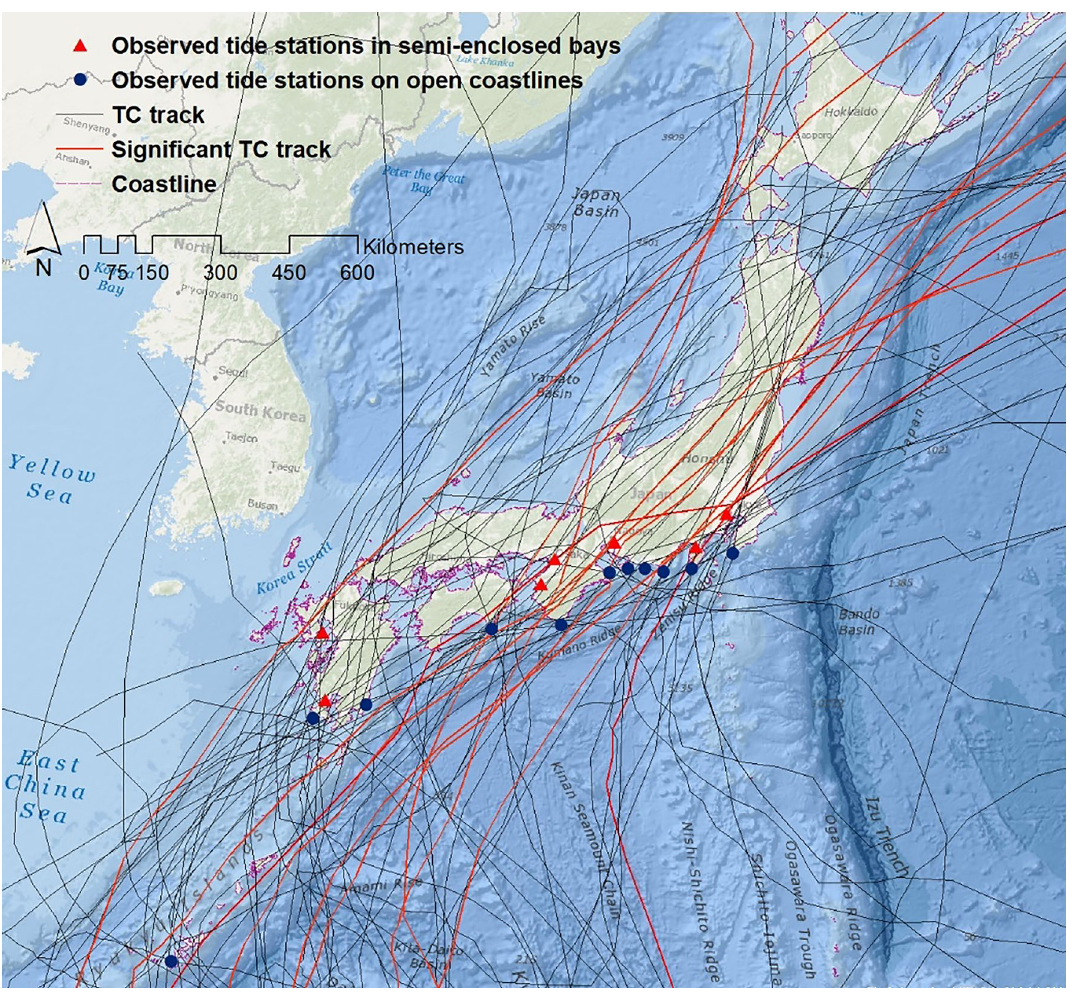
Figure 1. Best track for historical TCs 42 making landfall (based on the criteria used in this study) during 1978– 2019 over the four major Japanese islands (Honshu, Shikoku, Kyushu, and Okinawa). Two different symbols indicate seven stations in semi-enclosed bays and 11 stations in open coasts. Map is created using ArcMap (v.